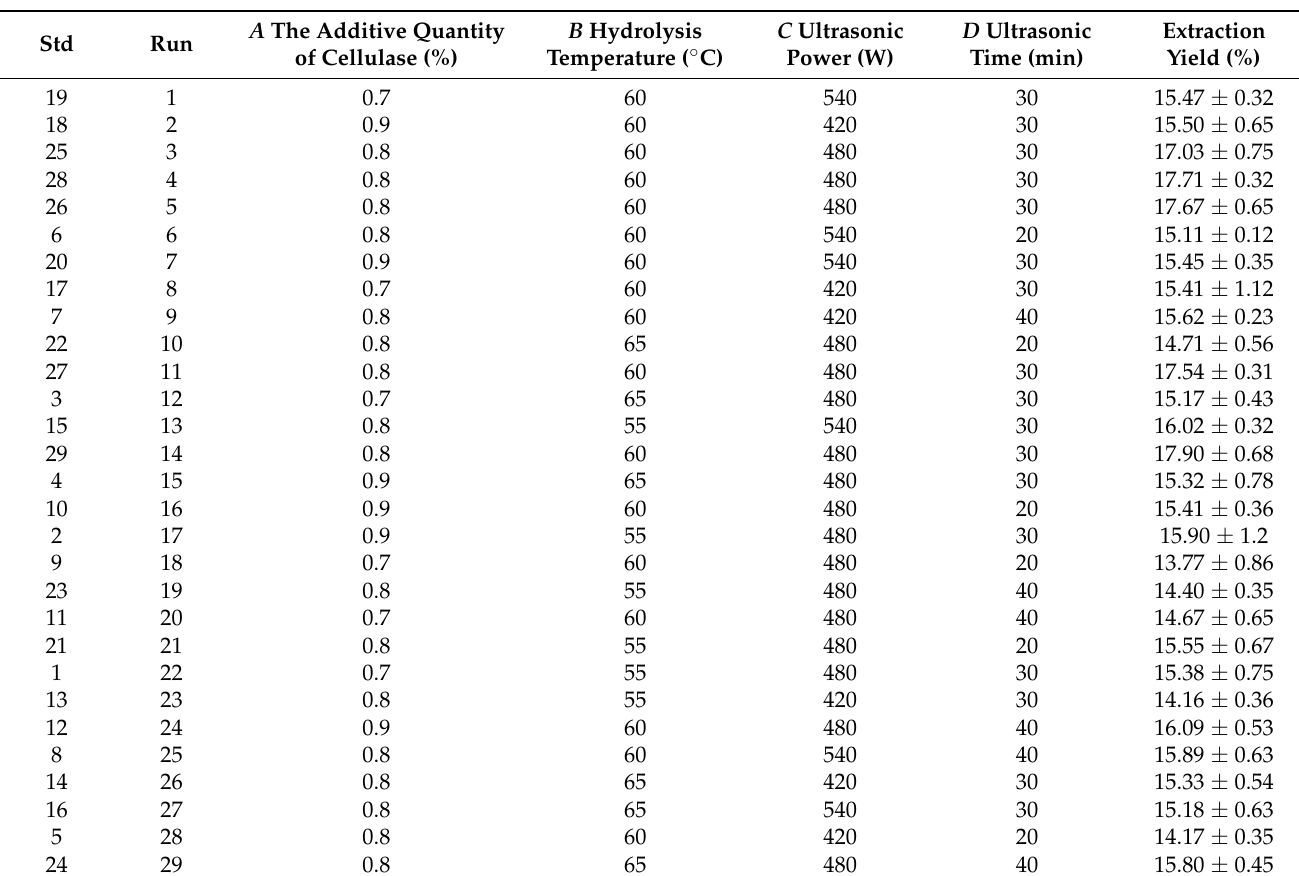
Table 3. Box–Behnken test results.